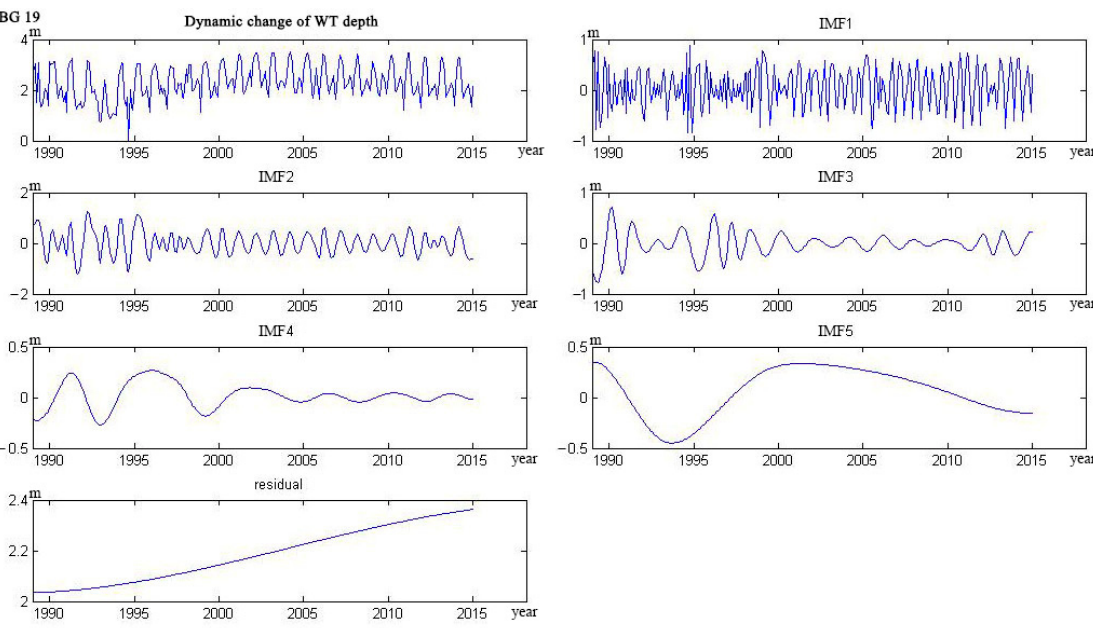
Figure A15. Decomposition of groundwater time series data of well BG23.